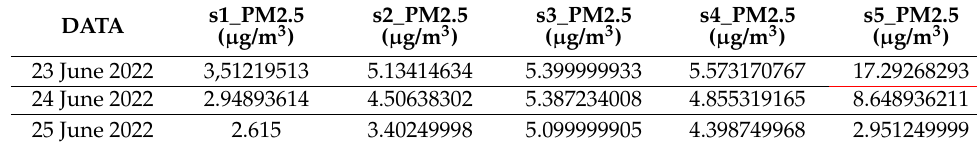
Table 3. Detected average of the PM 2.5.